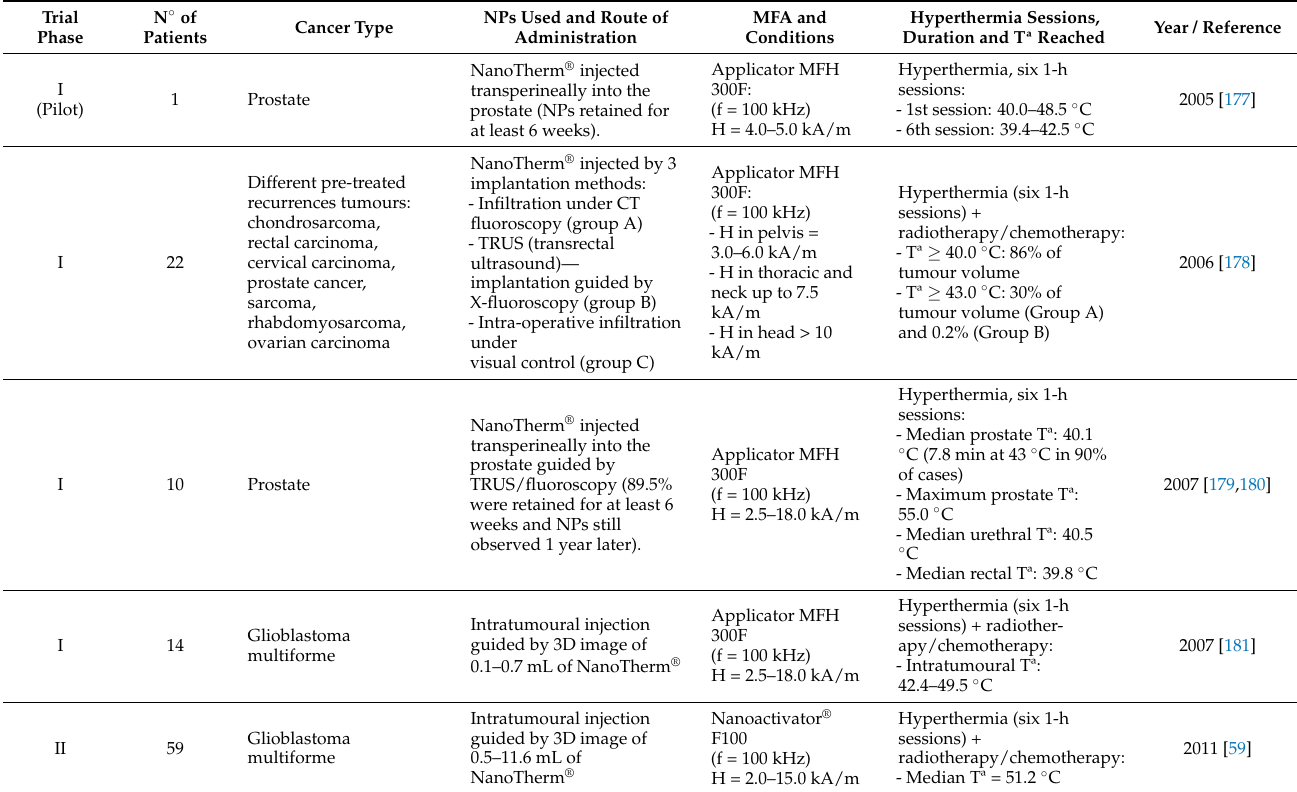
Table 2. Summary of the different MHT clinical trials carried out by Charit é